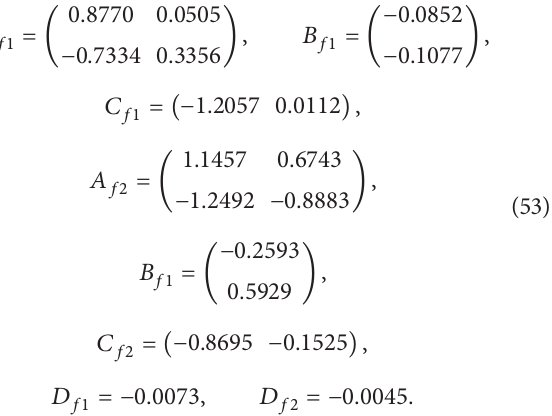
Figure 2: 𝐻 ∞ noise-attenuation level bound 𝛾 = 4.0988 .